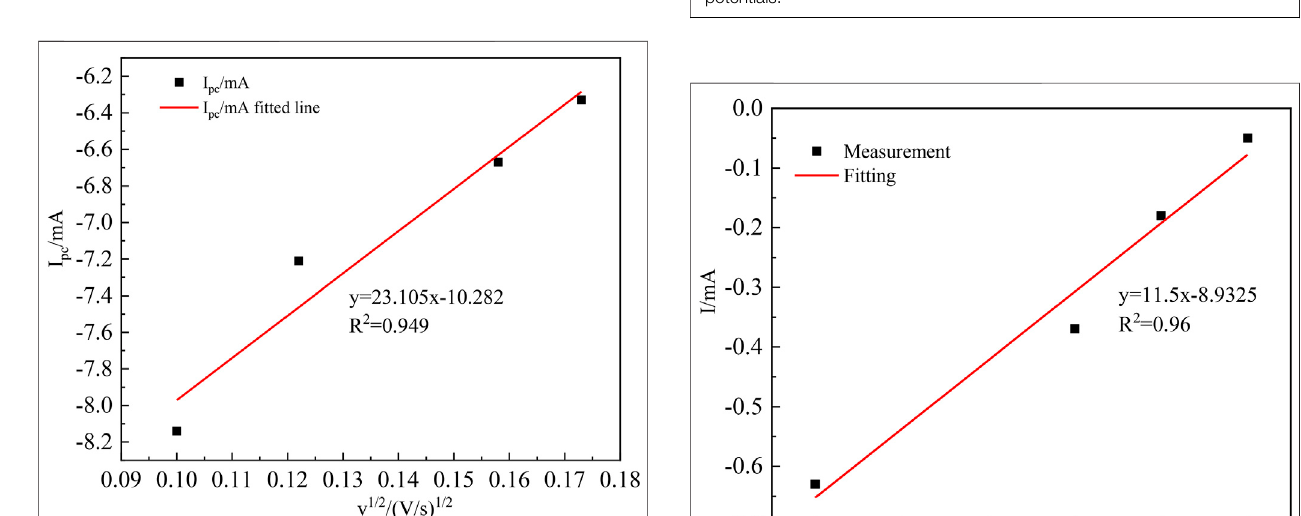
FIGURE 5 | Chronoamperometric current curves for In 3+ at different potentials.